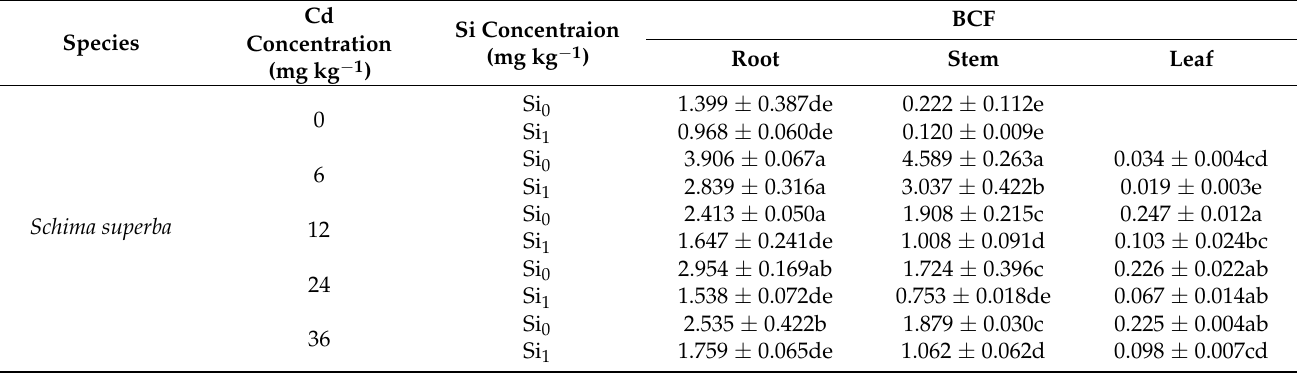
Table 4. Effects of Cd and Si on BCF values of the